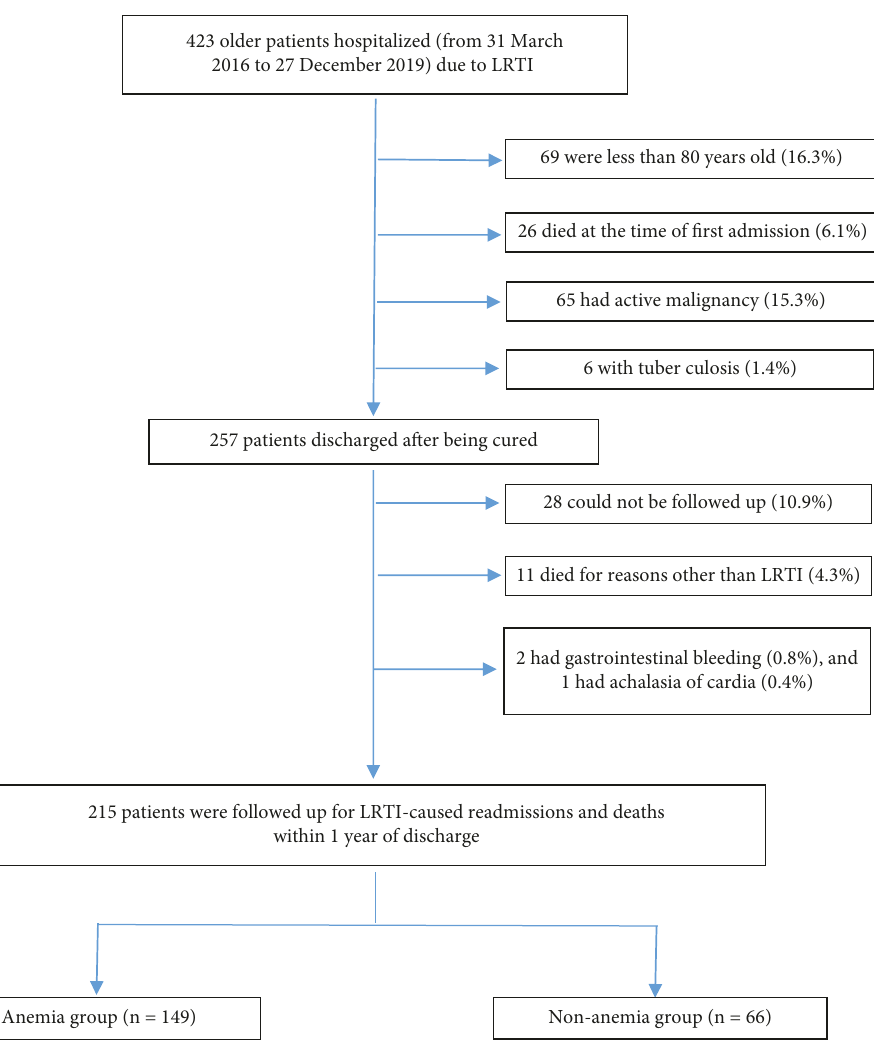
Figure 1: Cohort